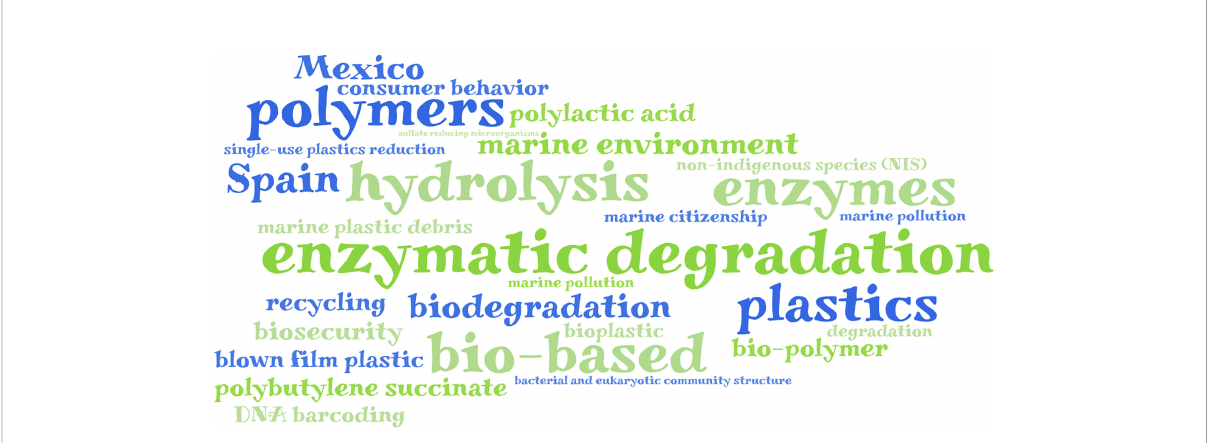
FIGURE 1 Word cloud generated from the keywords from the fi ve papers contributed toward this Frontiers in Marine Science Research Topic [generated through WordArt.com - Word Cloud Art